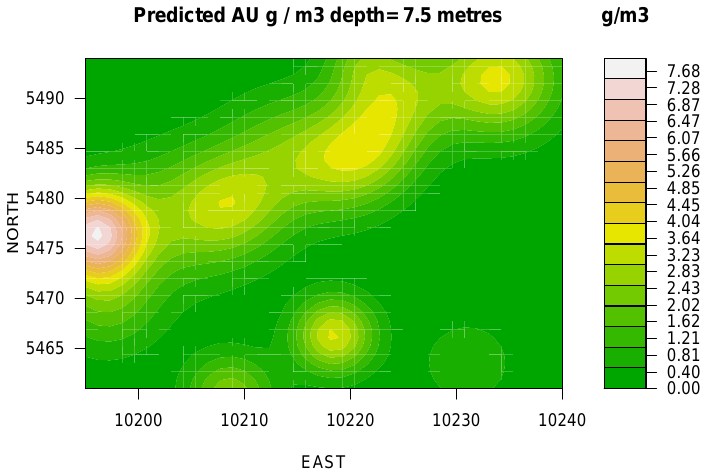
Figure 5. A realization of cross-section at depth of 7.5 m. The apparent Au grade increases considerably with the increase of depth. Contours illustrate a preferential trend in the northeasterly direction. The extraction of the underlying level, i.e., below RL445 can be economically profitable. The adjacent flitch at the Easterly locality requires careful grade